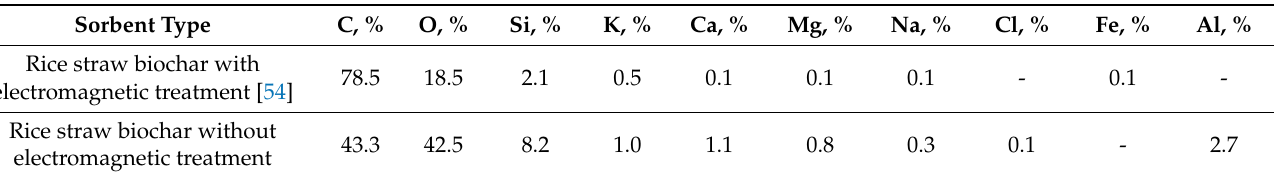
Table 5. Chemical composition of the obtained samples of activated rice straw biochar and without activation by electromagnetic treatment.